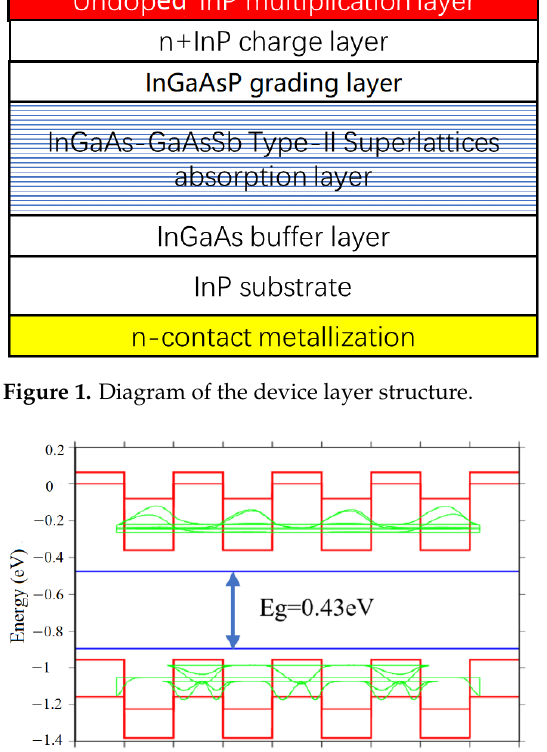
Figure 1. Diagram of the device layer structure.